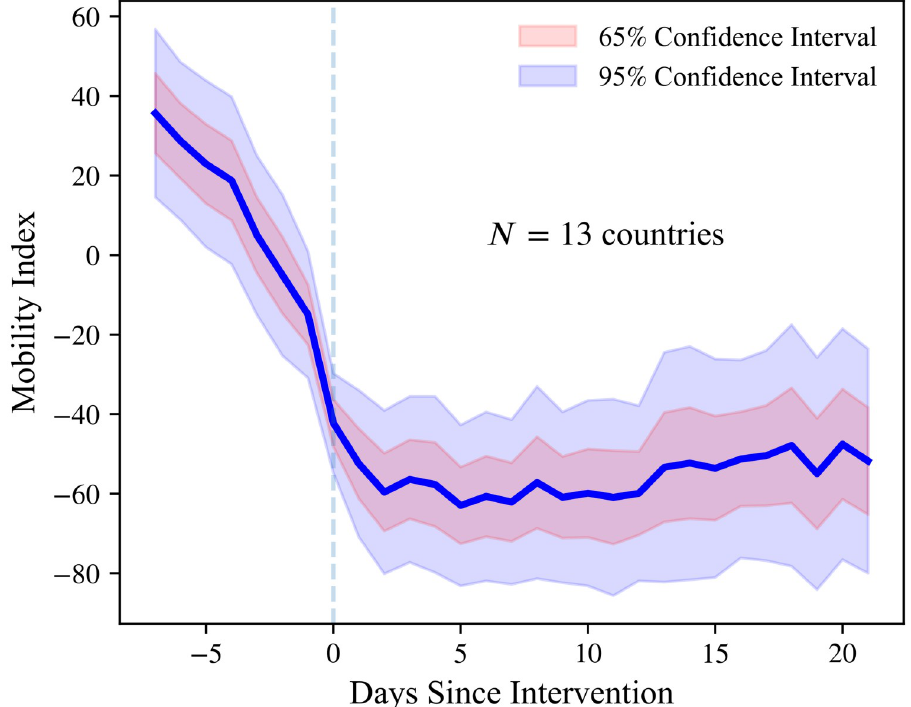
Fig 4. Mobility around introduction of lockdowns. Mobility index (constructed from Google’s “COVID-19 Community Mobility Reports” [24]) one week before and three weeks after a lockdown is introduced in a country. See S1 Appendix (Section A.8) for details on the construction of the mobility index. The original sample consists of 14 European countries studied by Flaxman et al [25]. Heteroskedasticity-robust confidence bounds are shown by the shaded